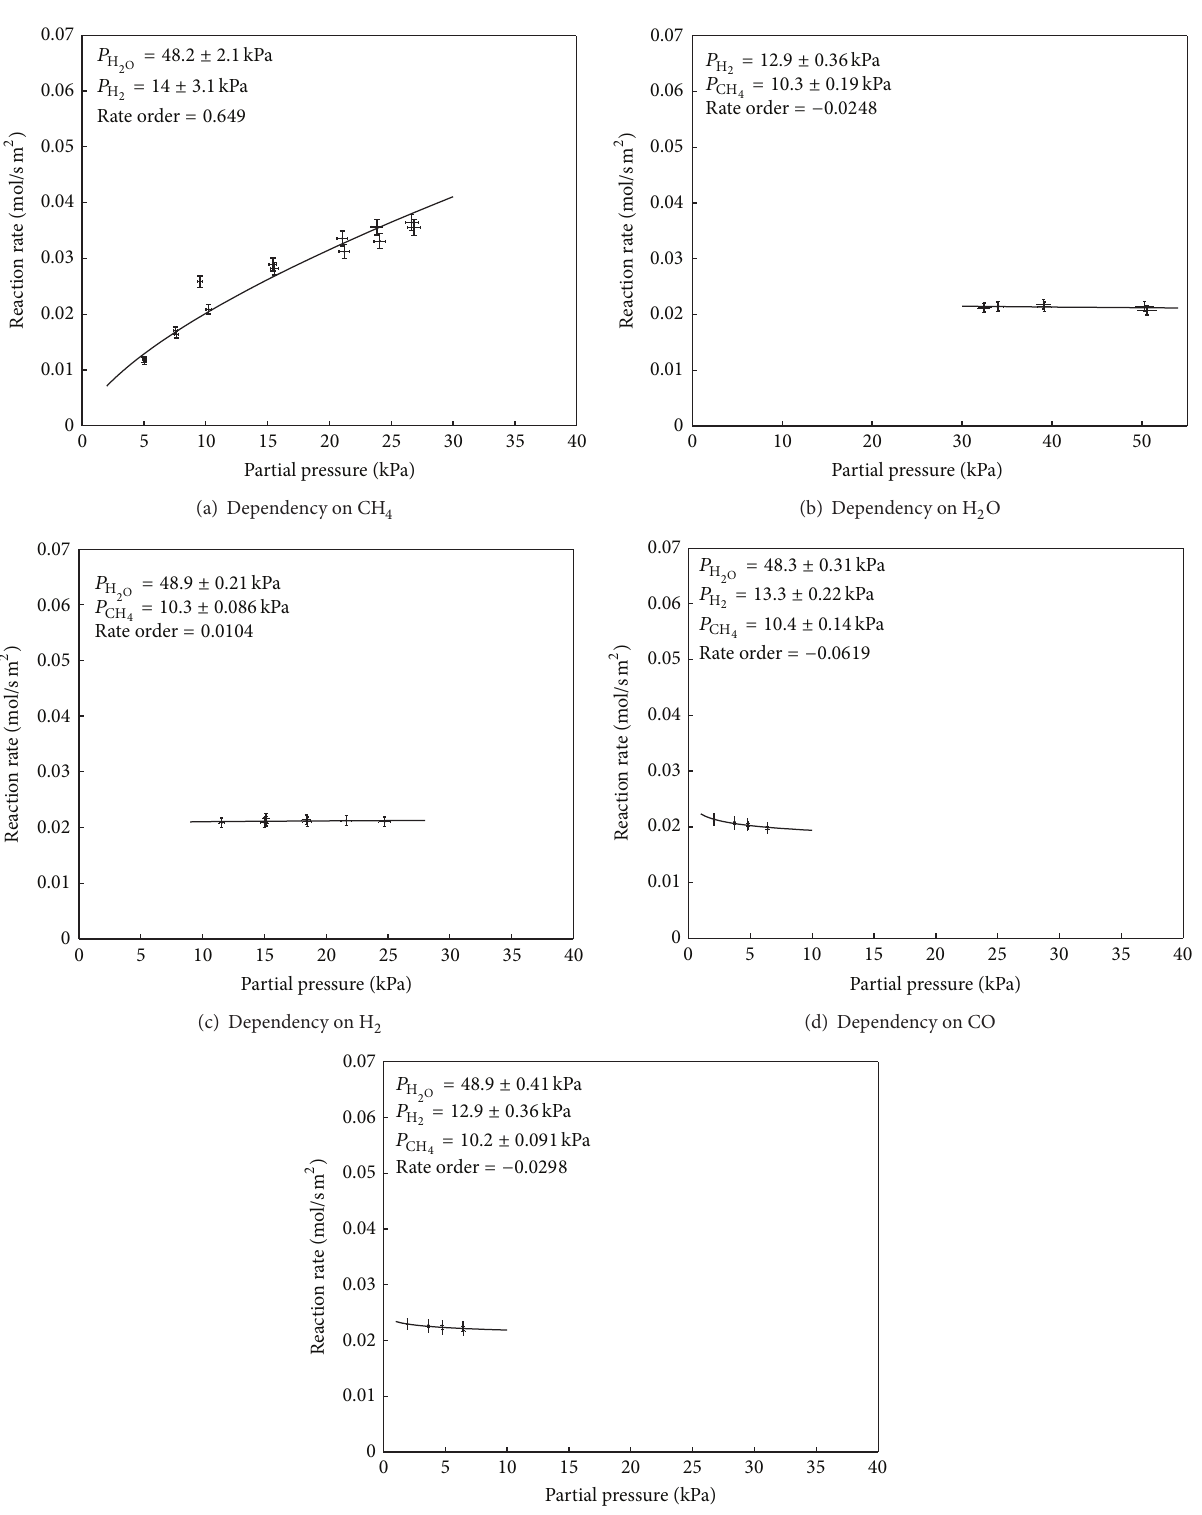
Figure 4: Corresponding measured rates and dependencies of the different gas species over the quarter cell stack at 750 ∘